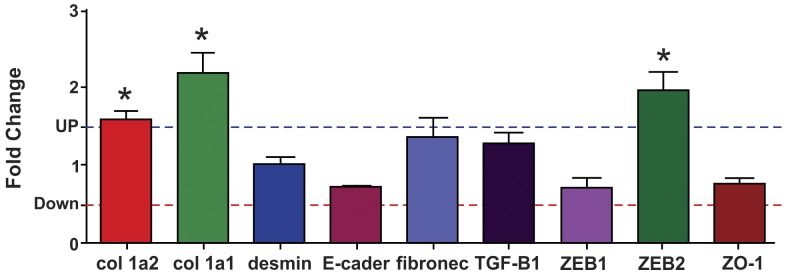
Expression levels of mRNAs.Expression levels of col 1α1, col 1α2, desmin, E-cadherin, fibronectin, TGF-β1, ZEB1, ZEB2 and ZO-1 estimated by SyBR green RT-qPCR in glomeruli of LP rats. The expression of each mRNA was normalized for GAPDH, β-actin and TBP genes. Data are expressed as fold change (mean ± SD, n = 5) relative to control group (n = 5). *Significantly different from control group (P≤0.05).